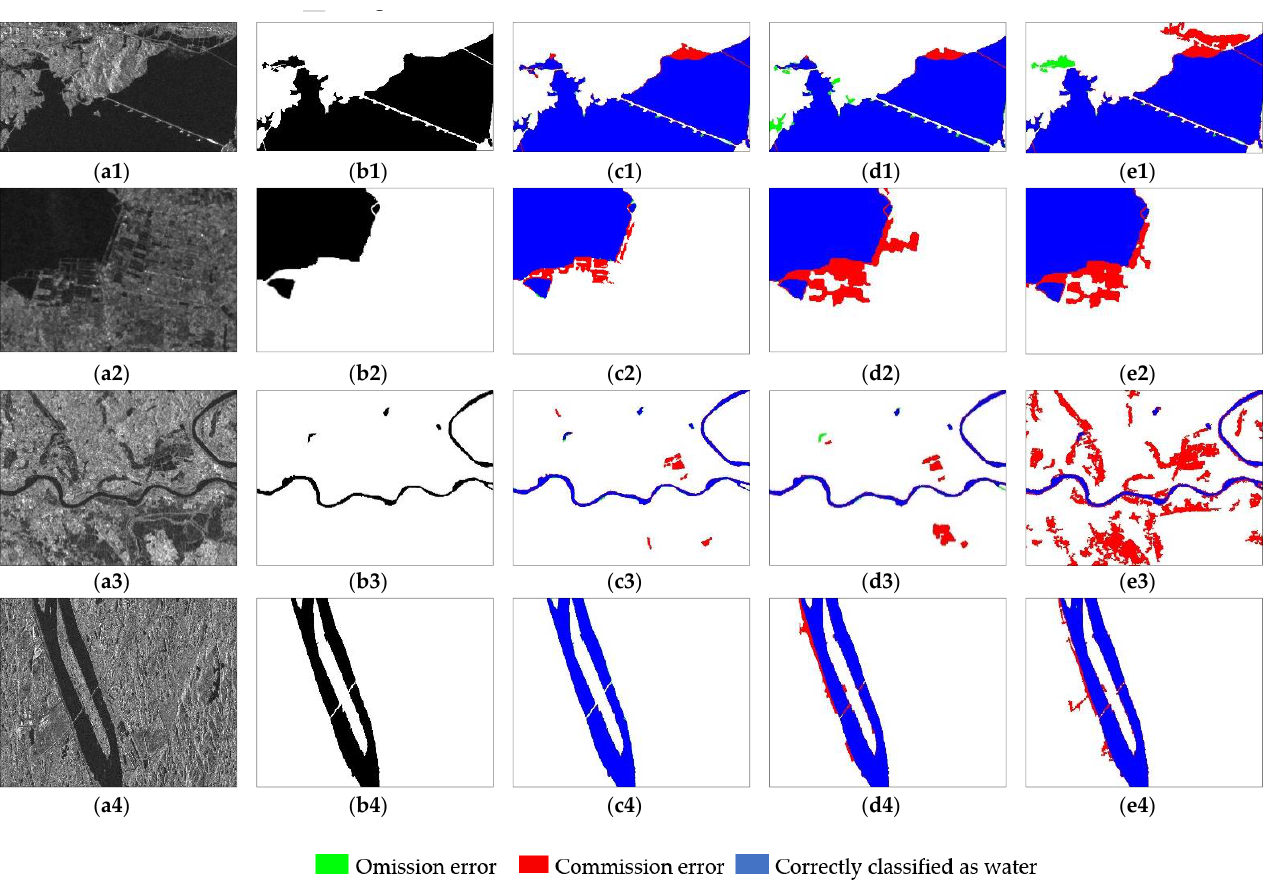
Figure 7. The above classification results for the zoomed-in region 1 (cid:13) – 4 (cid:13) of Data C–F. ( a ): SAR image, ( b ): the ground truth, ( c ): DTGC method, ( d ): IGC method, and ( e ): IACM method. The highlighted colors in results represent water (blue), omission error (green), and commission error